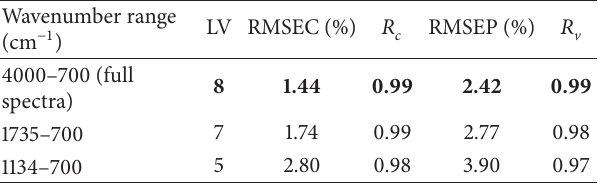
Table 3: Performance results of PLS models based on different data ranges.